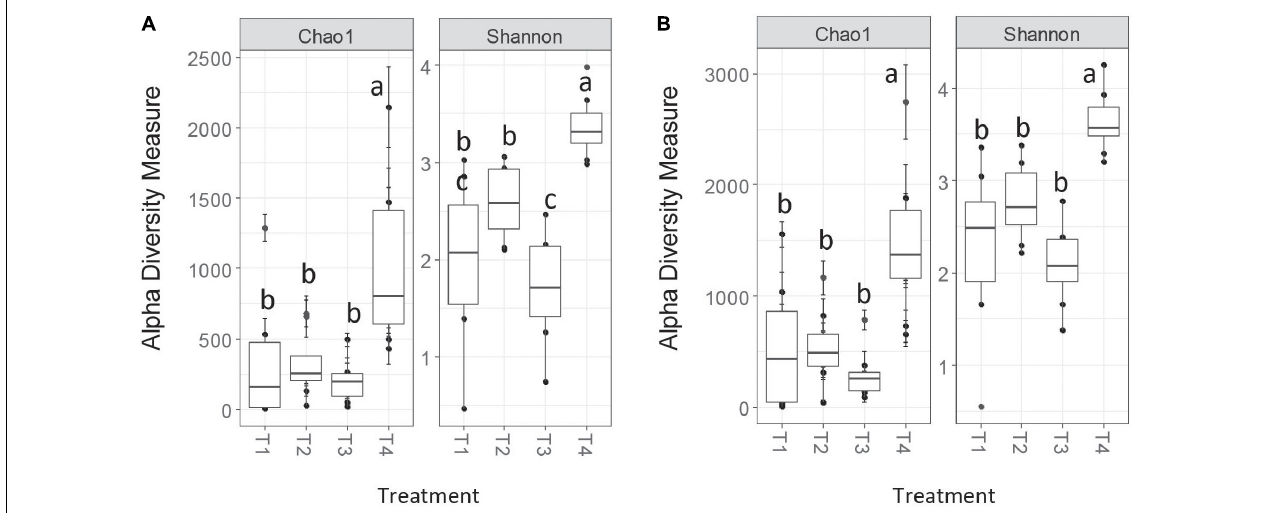
FIGURE 2 | Chao1 and Shannon alpha diversity measures for nifH for AGC-0.03 (A) and MCC-0.03 (B) methods. Letters indicate significance at α < 0.05 via ANOVA with Tukey’s HSD correction for multiple comparisons.